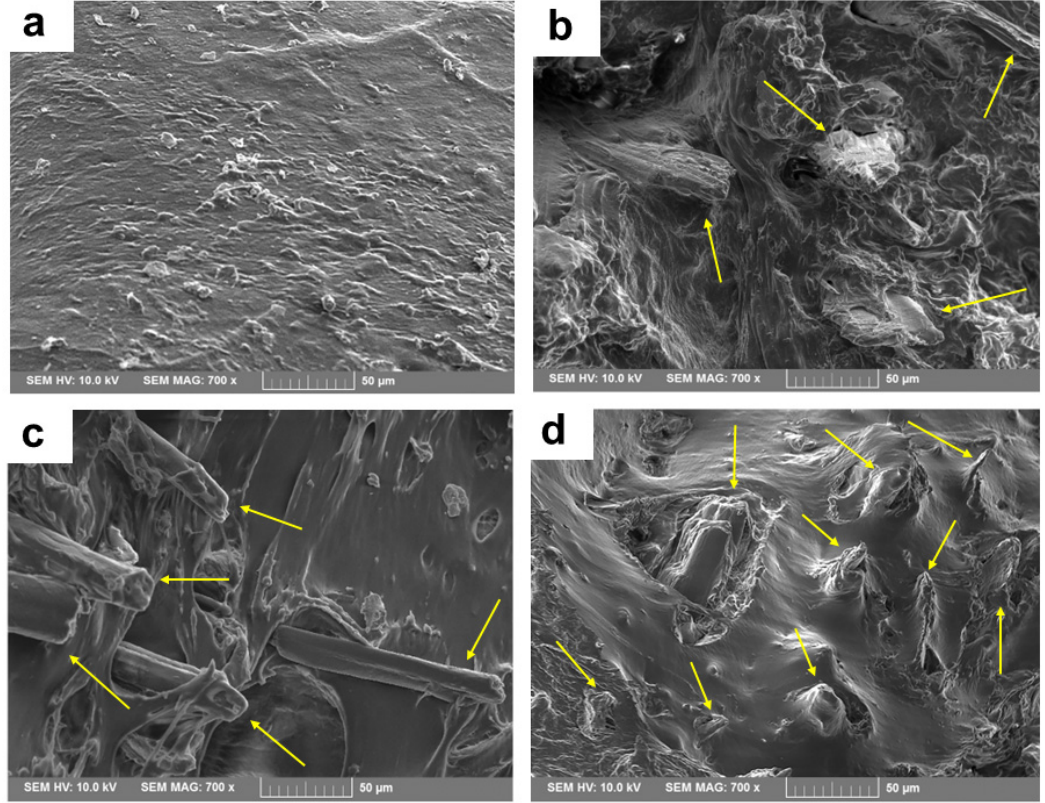
Figure 6. FE-SEM pictures of tensile fractured PNF/SEBS composites: ( a ) SEBS, ( b ) PNF-10, ( c ) PNF-20, and ( d ) PNF-30.